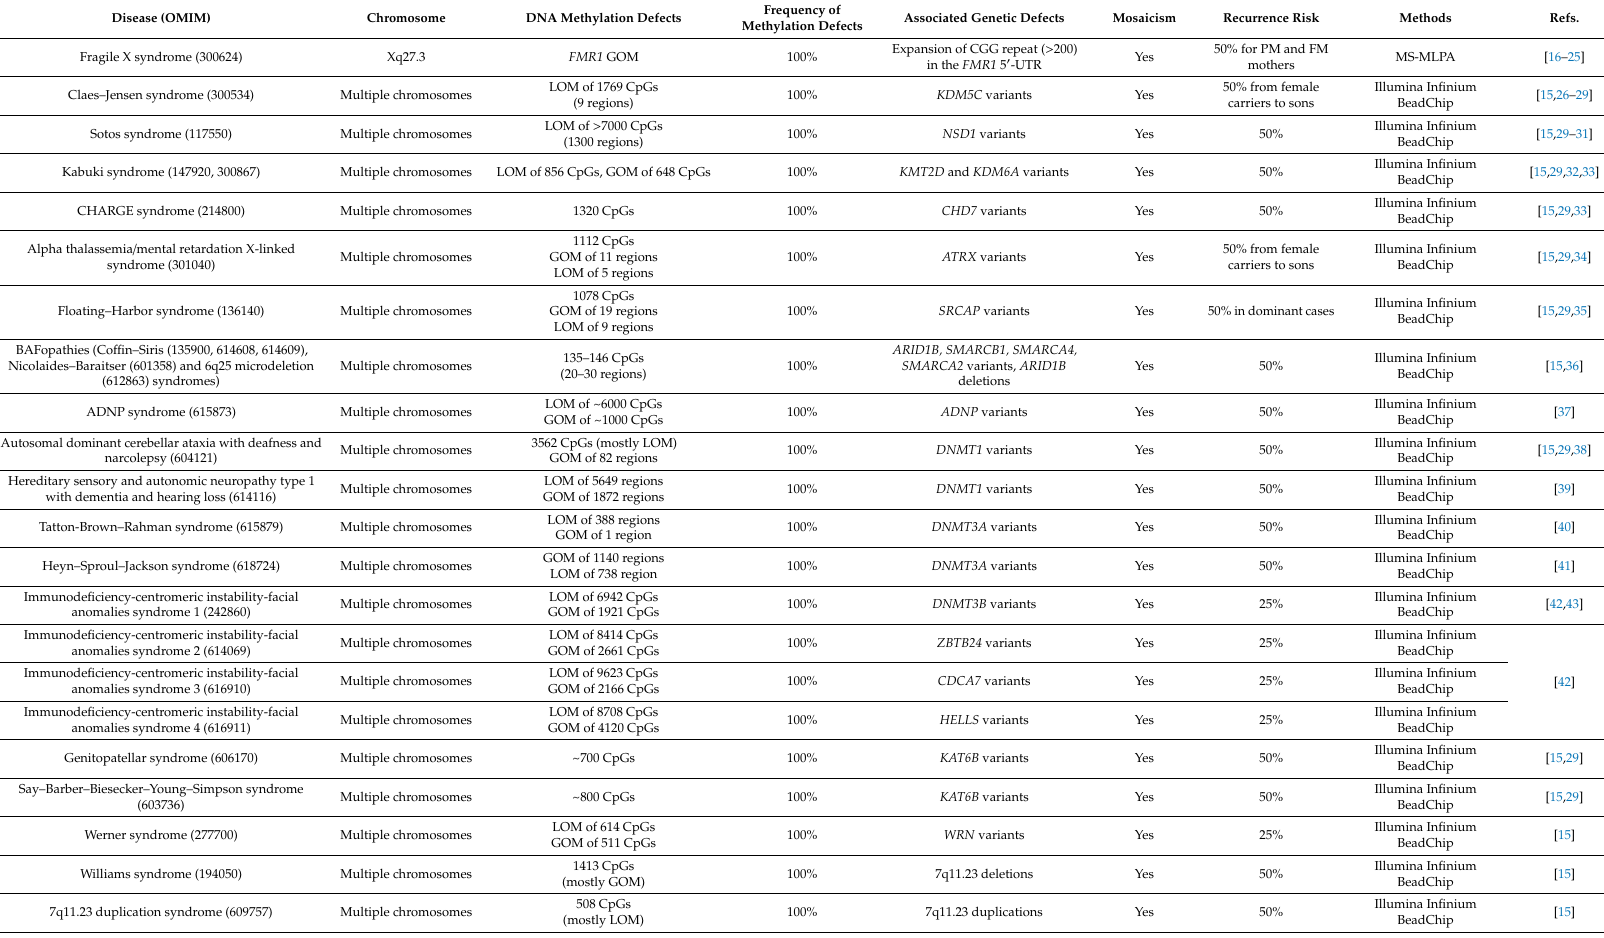
Table 1. Description of DNA methylation abnormalities in mono / oligogenic